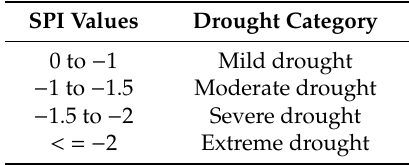
Table 1. Drought categories defined for SPI